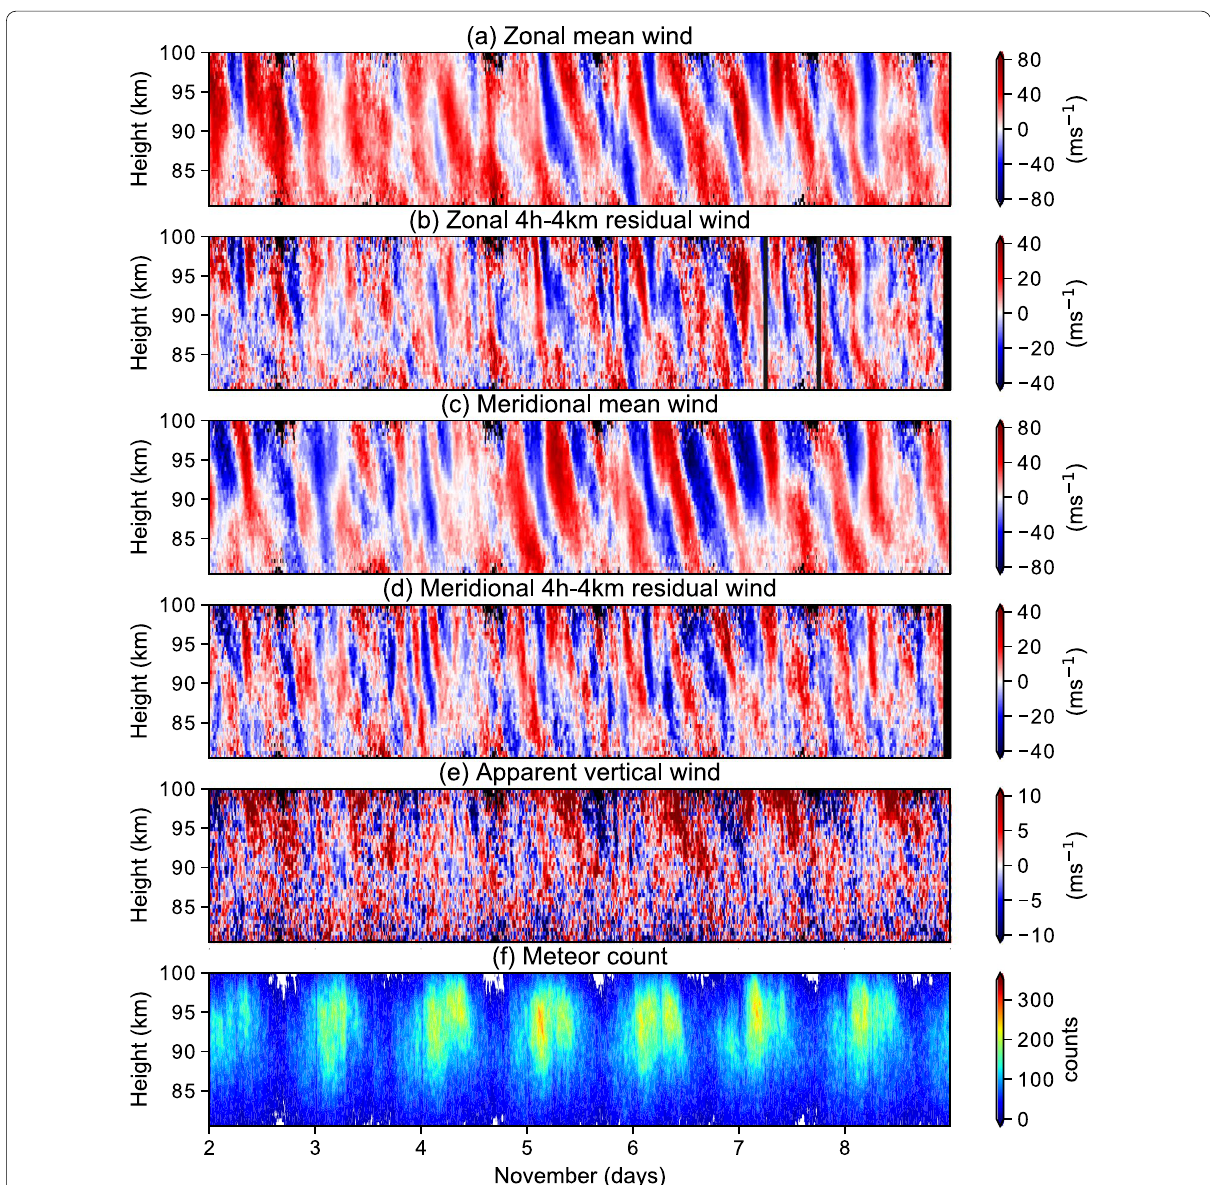
Fig. 2 a – e Mean zonal, residual zonal, mean meridional, residual meridional, and apparent vertical wind velocities estimated from the SIMONe 2018 Campaign data from Nov 2 to Nov 9, 2018. Panel f shows the meteor counts during the campaign period. Mean winds were estimated using specular meteor events that occurred at a given altitude during 30 min and 1 km time-altitude bins and inside the total radar illuminated